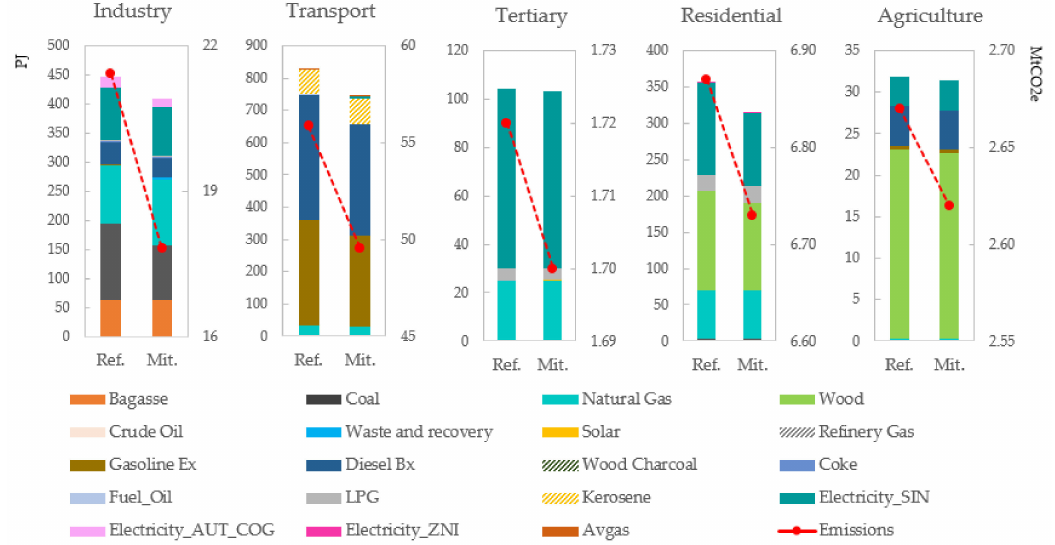
Figure 4. Energy demand and GHG emissions by demand sector in the reference and mitigation scenarios. Right axis in PJ and left axis in MtCO 2eq